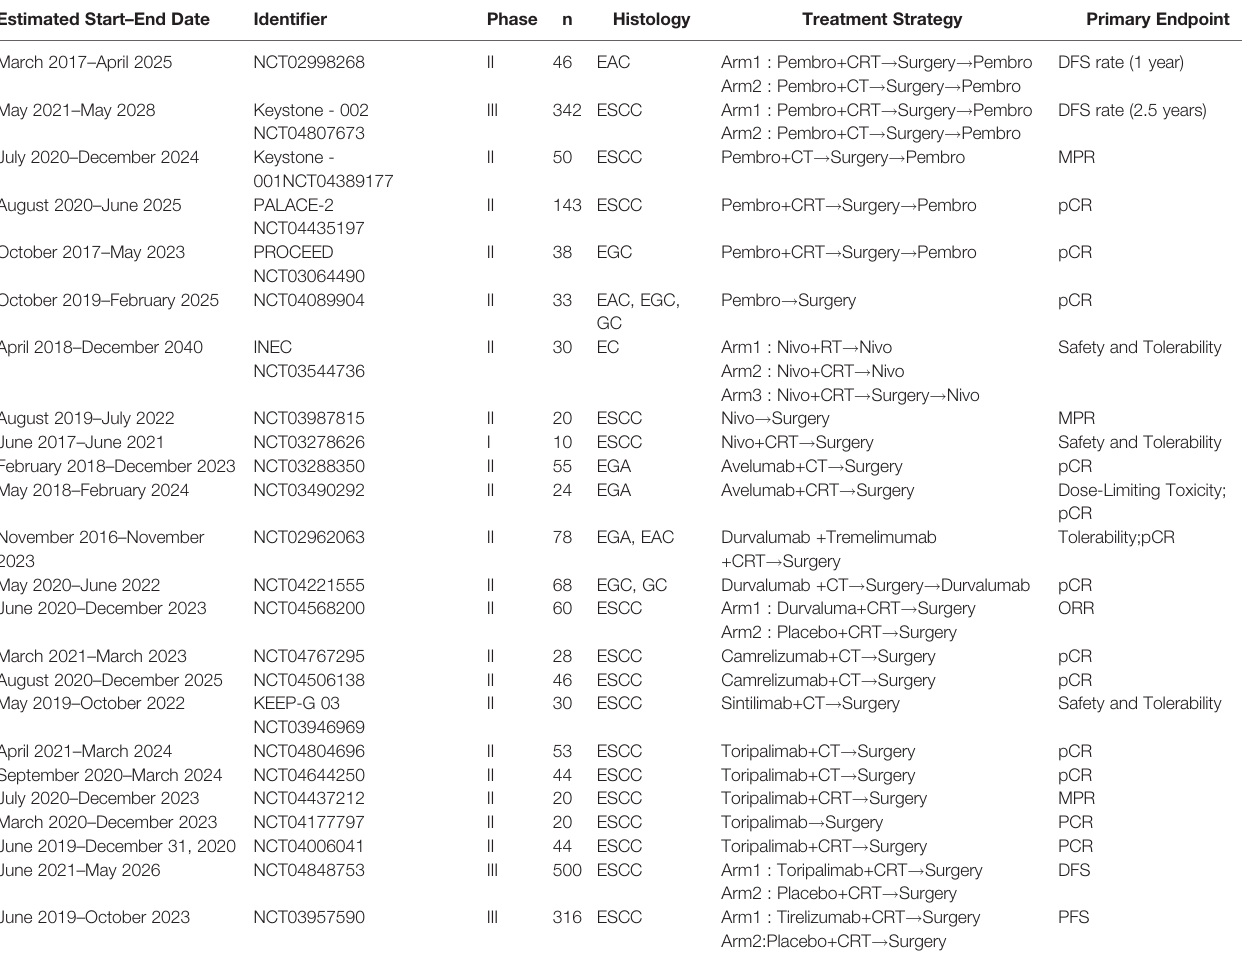
TABLE 1 | Summary of ongoing neoadjuvant immunotherapy studies for locally advanced esophageal